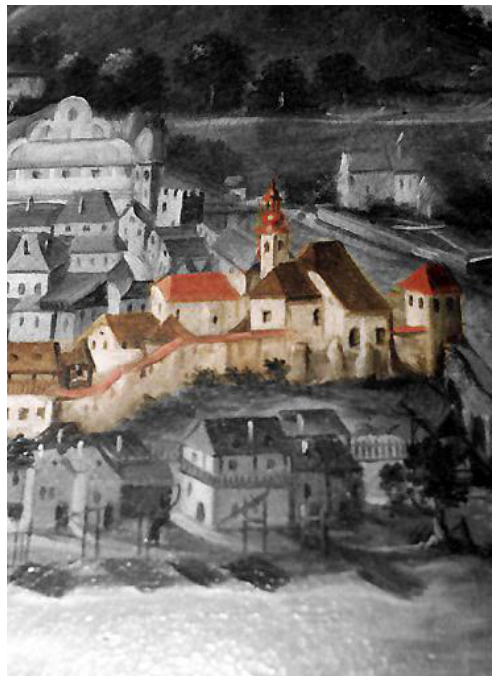
Figure 2. Townscape of Maribor, southeastern part of the town, with the synagogue and Jewish quarter highlighted, 1482, Regional Museum of Maribor.